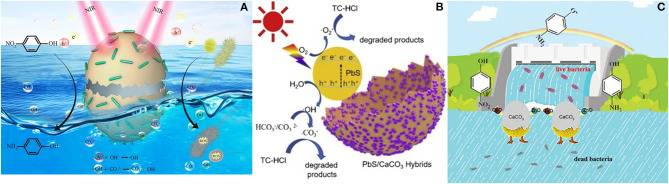
(A) Schematic representation of 4-NP degradation using CaCO3/CuS. Reprinted from Zhang et al. (2020b), Copyright (2020) American Chemical Society; (B) Illustrative degradation of TC-HCl over PbS/CaCO3 catalyst. Reprinted from Zhang et al. (2020a), Copyright (2020), with permission from Elsevier; (C) Schematic representation of 4-NP degradation using CuO/ZnO/eggshell. Reprinted by permission from Springer Nature Customer Service Centre GmbH: Springer Nature (Zhang et al., 2019a), Copyright (2019).